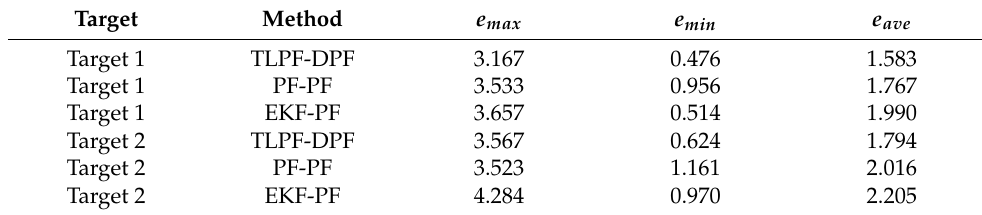
Table 1. Comparison of positioning errors with Gaussian noise.